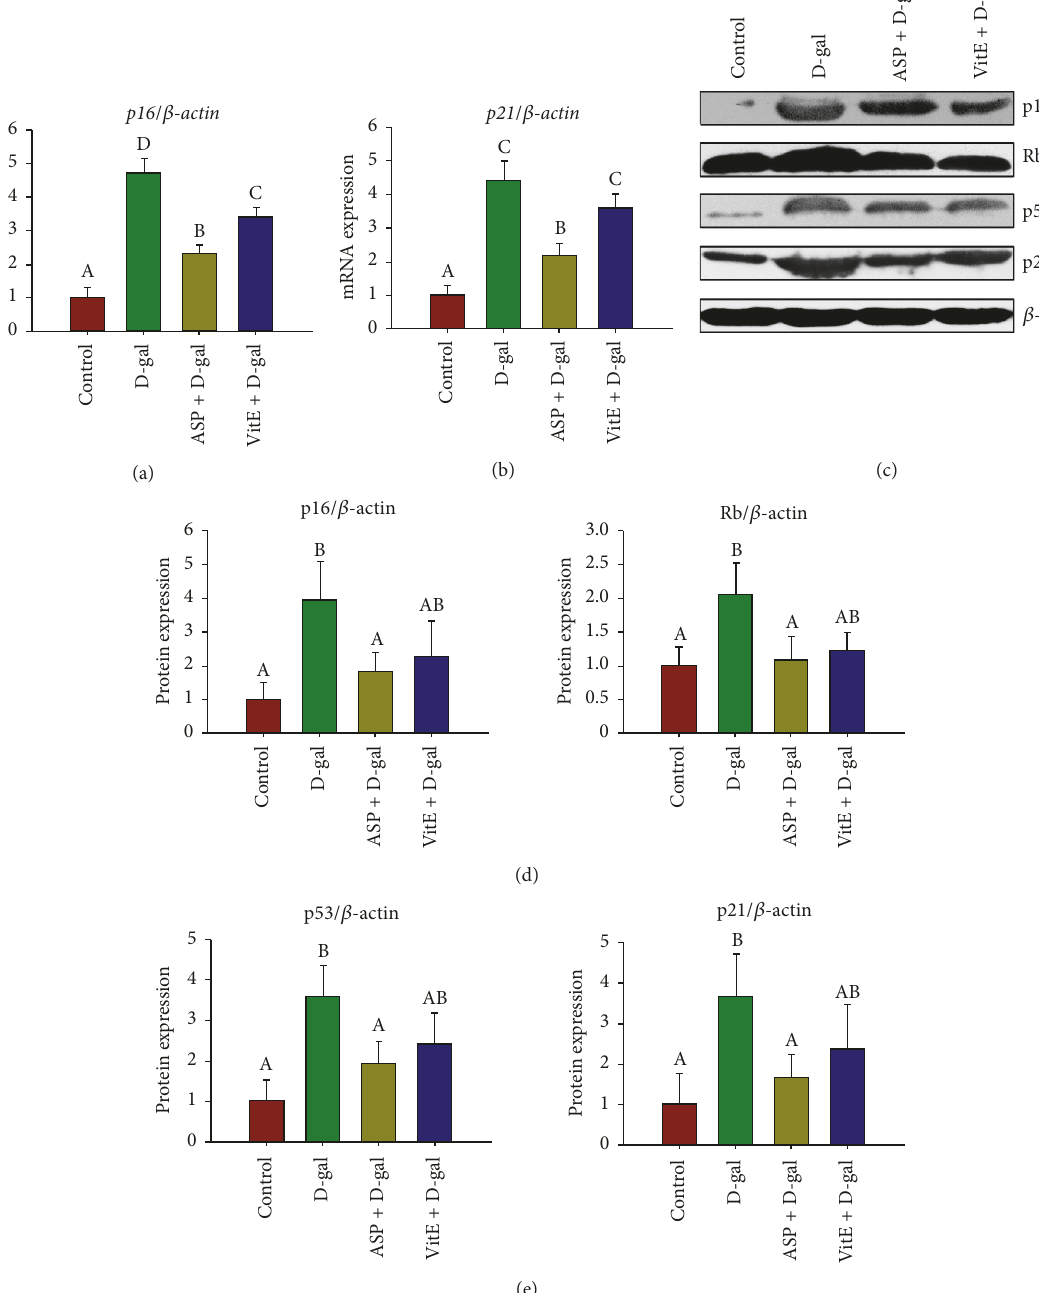
Figure 3: Effect of ASP on mRNA and protein expression of p16 INK 4 a -Rb and p53-p21 Cip 1/ Waf 1 of Sca-1 + HSC/HPCs in D-gal-induced aging mice. The Sca-1+ HSC/HPCs were collected after the treatment. (a) p16 mRNA expression analyses by qRT-PCR. (b) p21 mRNA expression by qRT-PCR. (c) The protein expression analyses of p16 INK 4 a , Rb, p53, and p21 Cip 1/ Waf 1 by Western blot, 𝛽 -actin was used as the internal control. (d) The relative protein expression of p16 INK 4 a -Rb signaling. (e) The relative protein expression of p53-p21 Cip 1/ Waf 1 signaling. Different letters: 𝑃 < 0.05